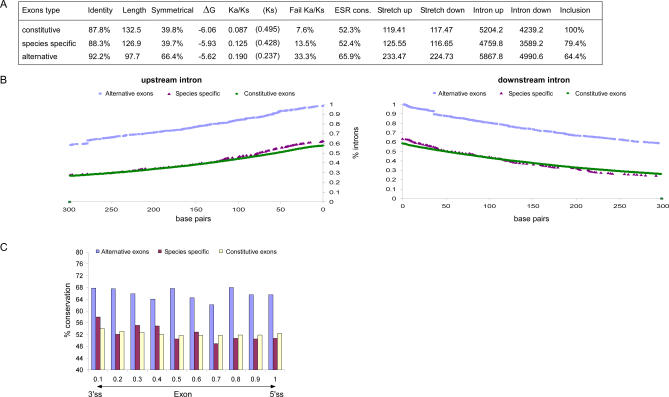
Species-Specific Exons Exhibit Characteristics of Constitutive Exons(A) Fifteen different characteristics that differentiate constitutively spliced exons from alternative cassette exons were examined on orthologous human and mouse exons that are constitutively spliced in one species but alternatively spliced in the other. We examined exon sequence conservation level between human and mouse (Identity), exon lengths (Length), percentage of exons in which the total number of nucleotides was divisible by 3 (Symmetrical), U1/5′ss binding strength (ΔG), the ratio between nonsynonymous and synonymous substitution rates (Ka/Ks), synonymous substitutions rate (Ks), the fraction of exons that fail the Ka/Ks likelihood ratio test (Fail Ka/Ks), the conservation of ESRs along the exons (ESR cons), the size of the flanking introns stretches that could be reliably aligned to the mouse ortholog for both upstream and downstream intron (Stretch up and Stretch down, respectively), the average size of the upstream and downstream introns (Intron up and Intron down, respectively), and the inclusion level of the exons (Inclusion). (B) Conservation level of the flanking intronic sequences. Median conservation level at each base position was calculated for the 300 base pairs upstream (left) and downstream (right) of the exon for constitutively spliced exons (green circles), alternative cassette exons (blue squares), and species-specific exons (red triangles). (C) The relative conservation level of ESRs between human and mouse, where the X axis is the location, from the 3′ss to the 5′ss, in 10% increments (exon size is normalized between 0 and 1) and the Y axis is the conservation level of the wobble positions between conserved human–mouse orthologous exons that are constitutively (yellow) and alternatively (blue) spliced in both human and mouse, or species-specific exons (red).